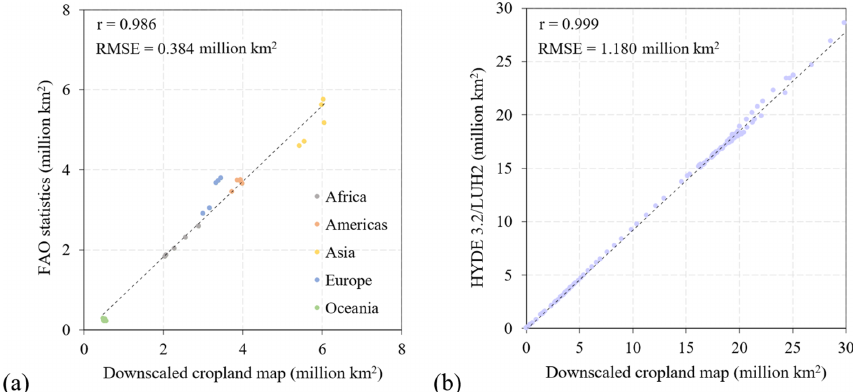
Figure 11. Comparison of cropland area between our downscaled map and (a) FAO statistics at the continental level for 1970CE–2010CE and (b) HYDE 3.2 and LUH2 at the global level for 10000BCE–2100CE under one historical and eight future scenarios. The black lines are the linear regression